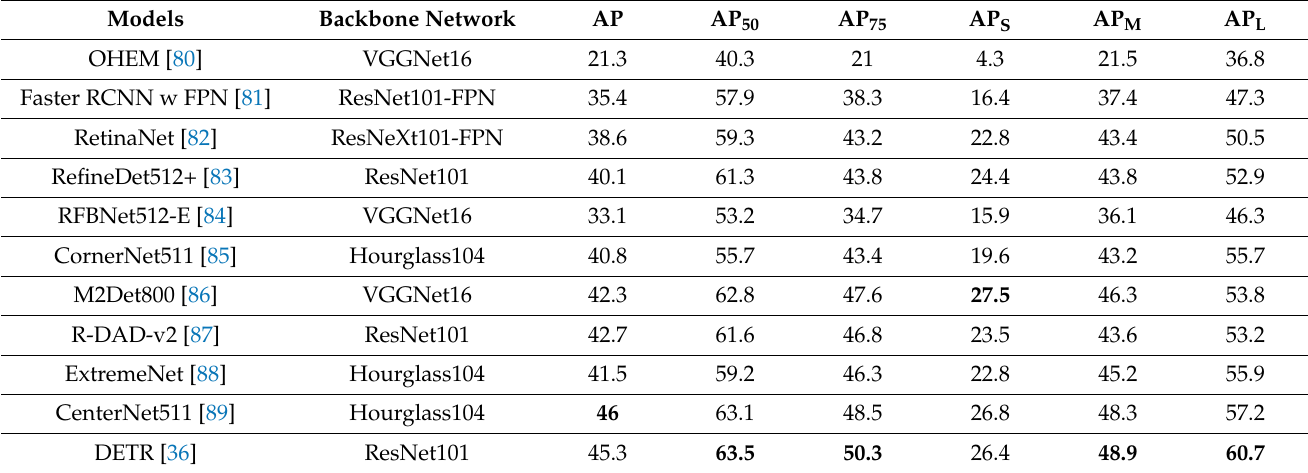
Table 4. The performance comparison of DETR with other state-of-the-art methods on LOL and ExDark datasets. The best results are marked with bold. S: small objects, M: medium objects, L: large objects.